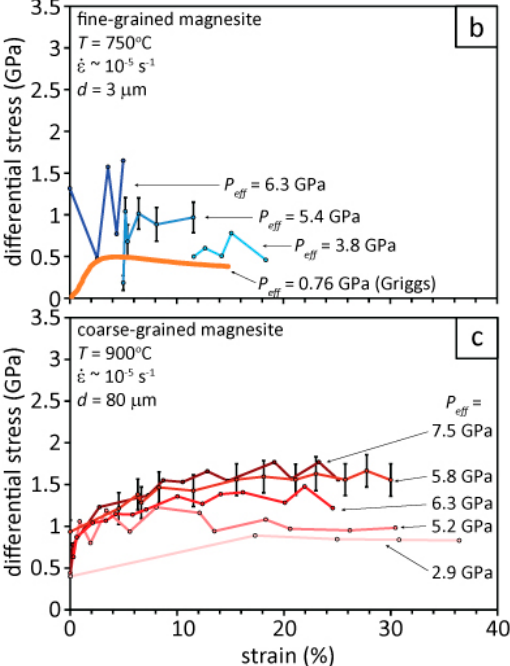
Figure 5. Strengths of fine-grained magnesite deformed at T = 500 °C ( a ) are greater than those of fine-grained magnesite deformed at T = 750 °C (b) and coarse-grained magnesite deformed at T = 900 °C ( c ). Fine-grained magnesite cylinders deformed at T = 500 °C strain harden during deformation ( a ) while the fine-grained magnesite cylinders deformed at T = 750 °C deform at relatively constant stresses or strain weaken ( b ). Coarse-grained magnesite cylinders deformed at T = 900 °C deform at relatively constant stresses ( c ). Strengths of magnesite cylinders in all sets increase as a function of increasing pressure.